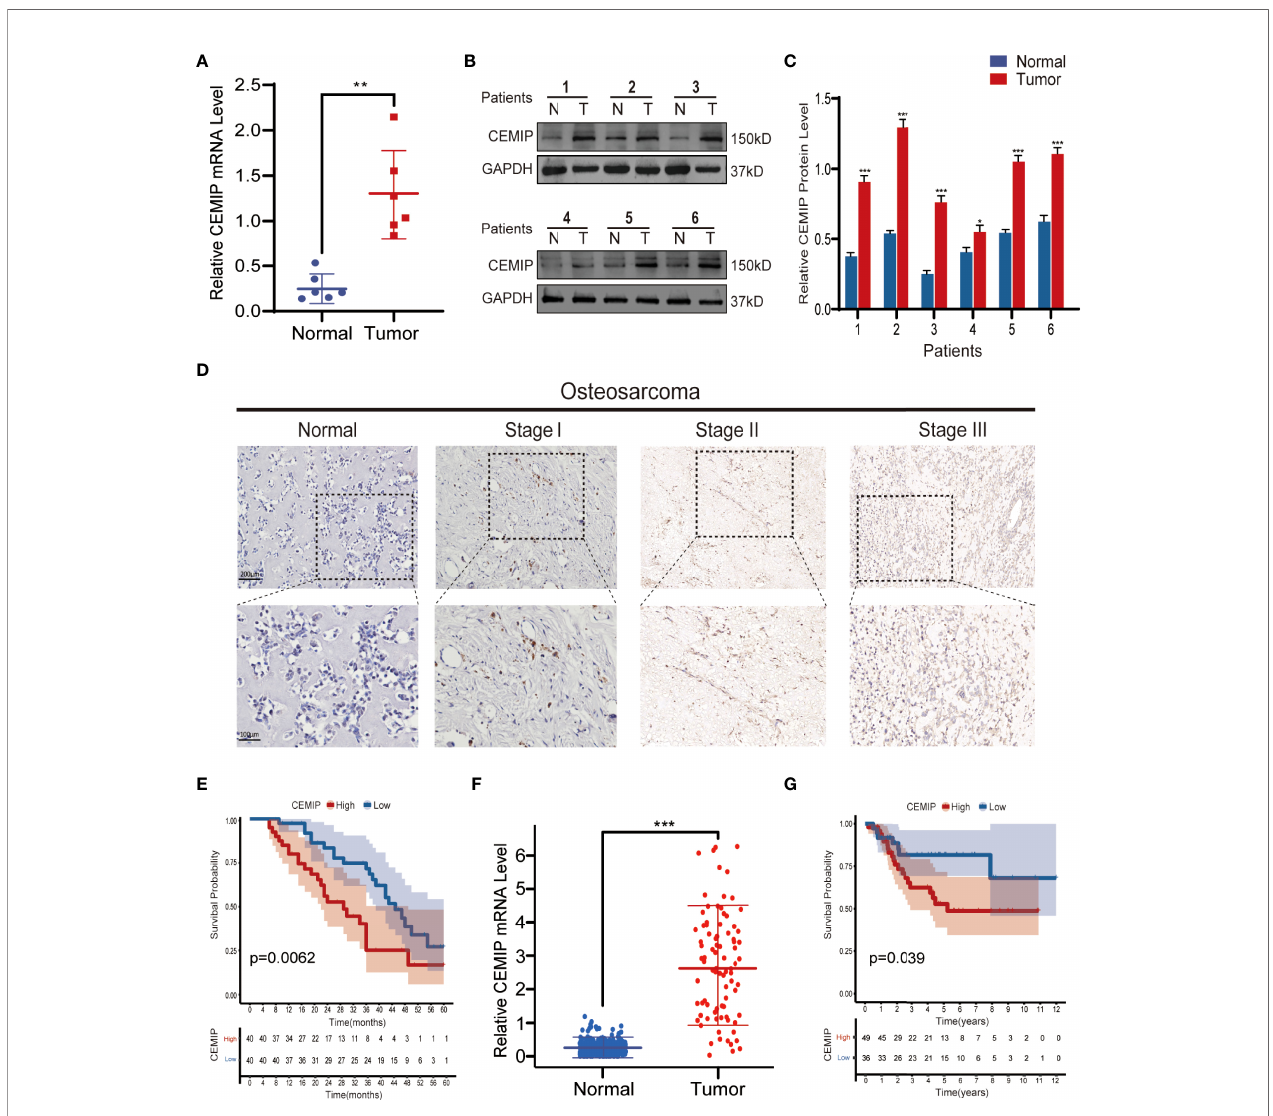
FIGURE 1 | CEMIP is overexpressed in osteosarcoma tissues and related to poor prognosis. (A) qRT-PCR analysis of CEMIP expression in six pairs of osteosarcoma tissues. (B, C) Western blot and its quantitative analysis showed CEMIP was overexpressed in six paired of osteosarcoma tissues and their normal adjacent tissues. (D) Immunohistochemical analysis of CEMIP expression in osteosarcoma tissues at different Enneking stages. (E) Survival analysis of CEMIP expression in osteosarcoma patients from in-house patients. (F) mRNA expression of CEMIP in osteosarcoma patients from the TARGET datasets. (G) Survival analysis of CEMIP expression in osteosarcoma patients from the TARGET datasets. * P < 0.05, ** P < 0.01, *** P <